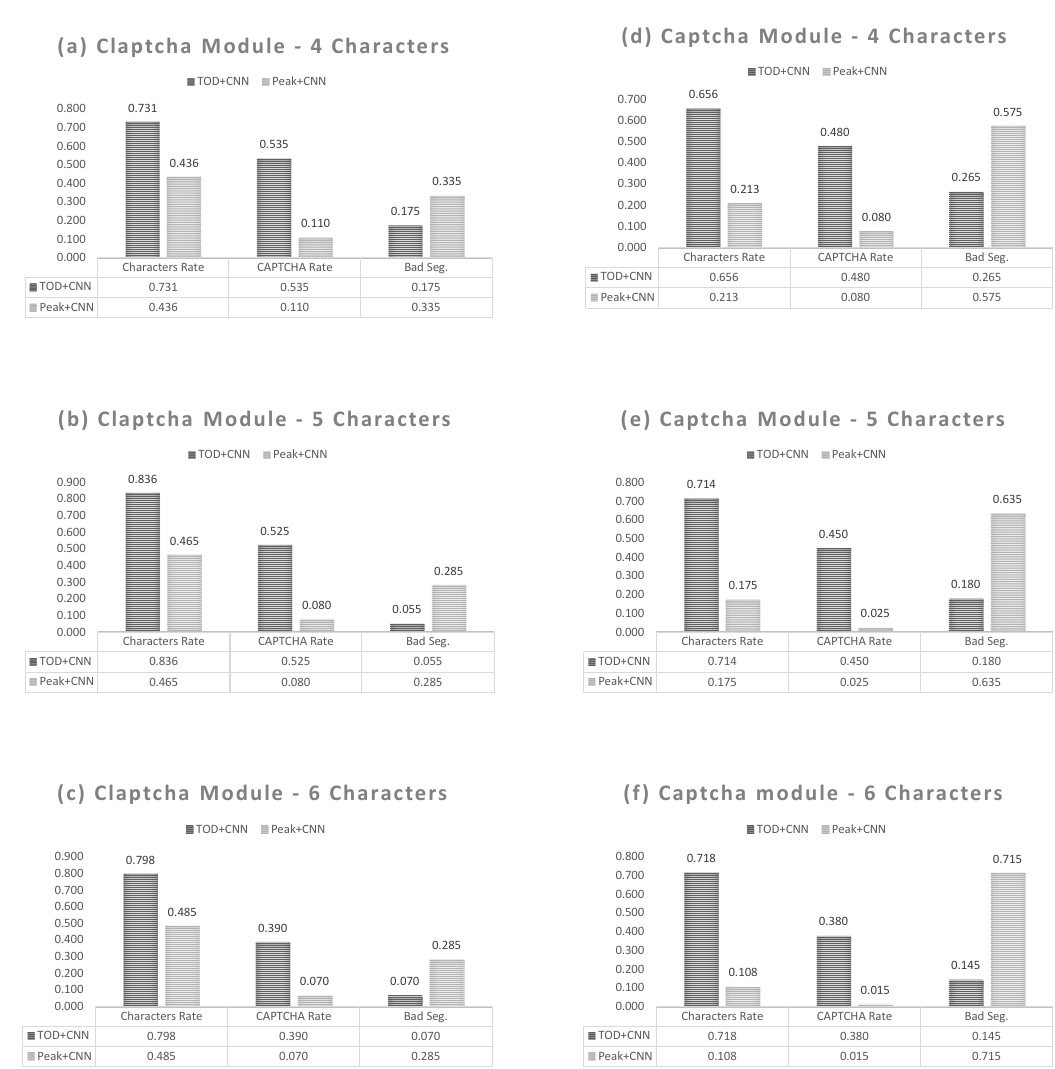
Figure 8. Test Results for Cracking Rate over Different Types of